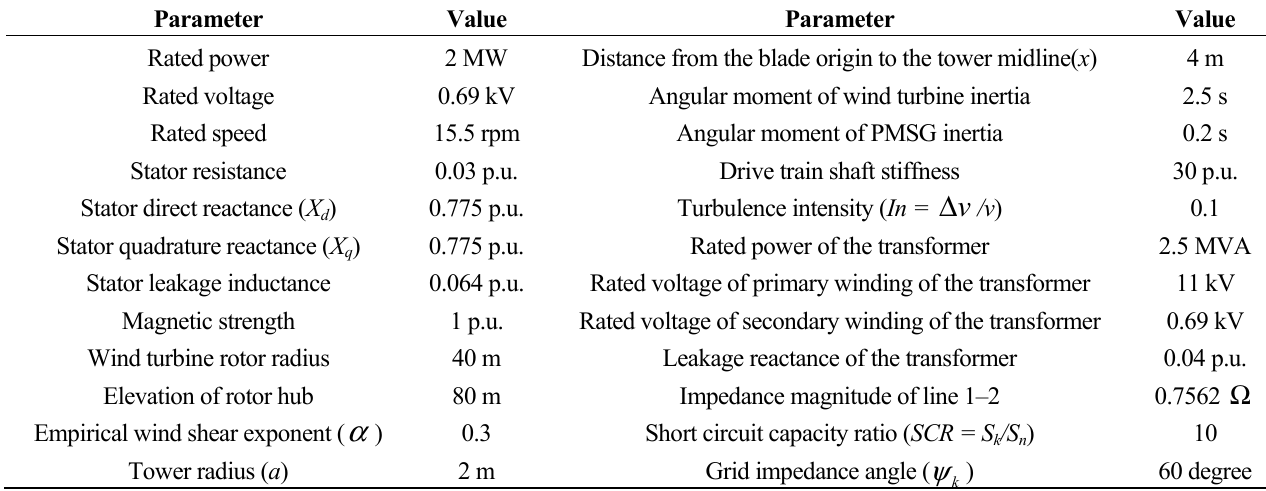
Table A1. The Parameters of The Variable Speed Wind Turbine with